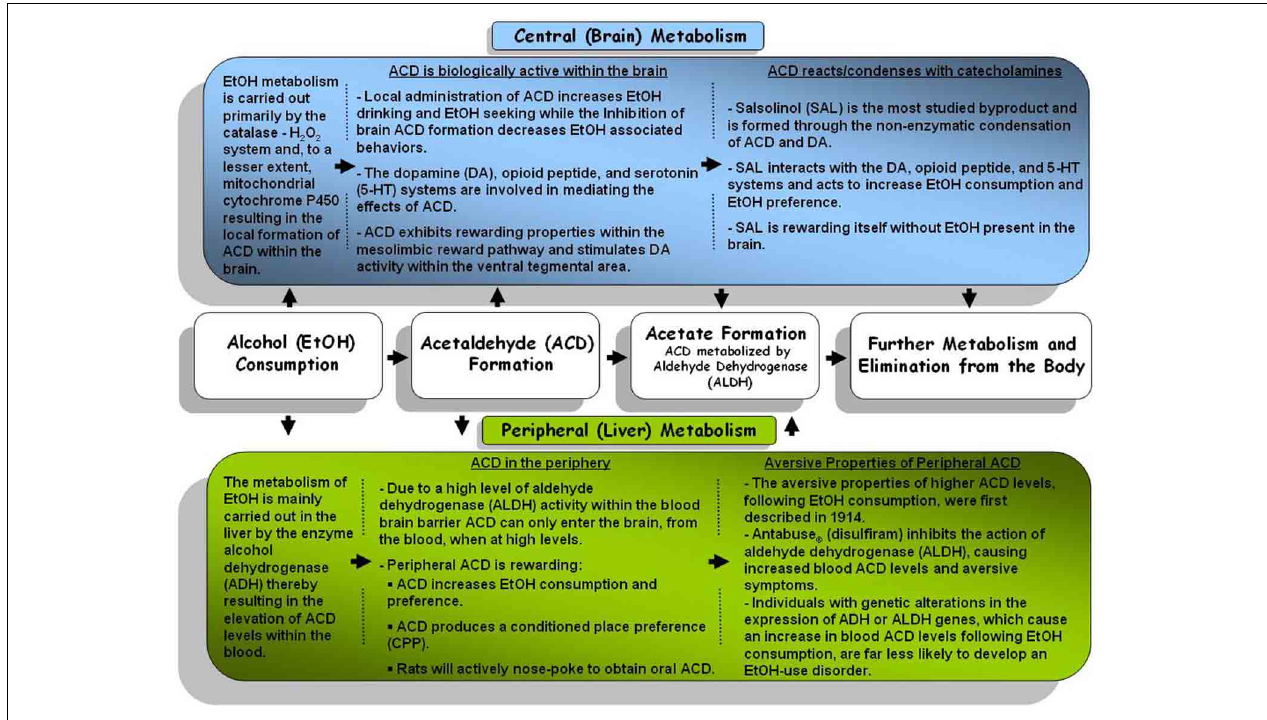
FIGURE 1 | A general schematic representation of the central (brain) and peripheral (body) metabolism pathways for alcohol and alcohol metabolites.